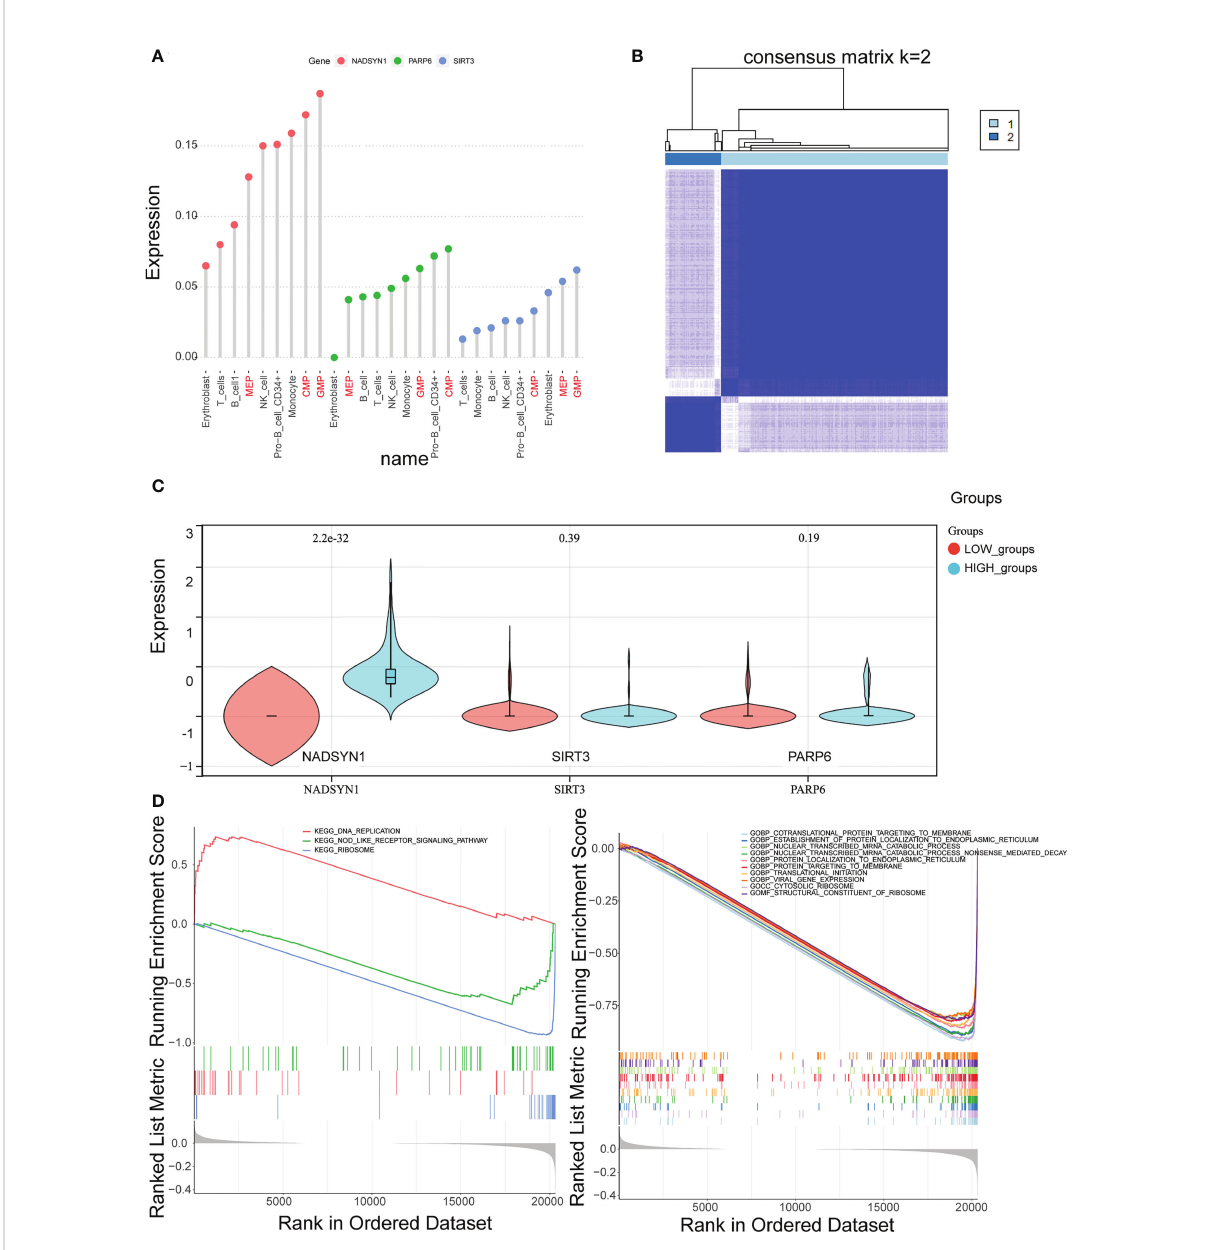
FIGURE 6 Identi fi cation of key cell clusters. (A) The distribution of the biomarkers expressions in different cell types to identify key cell clusters. (B) Correlation between the two clusters (k = 2). (C) The expression levels of biomarkers in the high- and low- expression groups. (D, E) . Gene Set Enrichment Analysis (GSEA) in the high- and low-expression